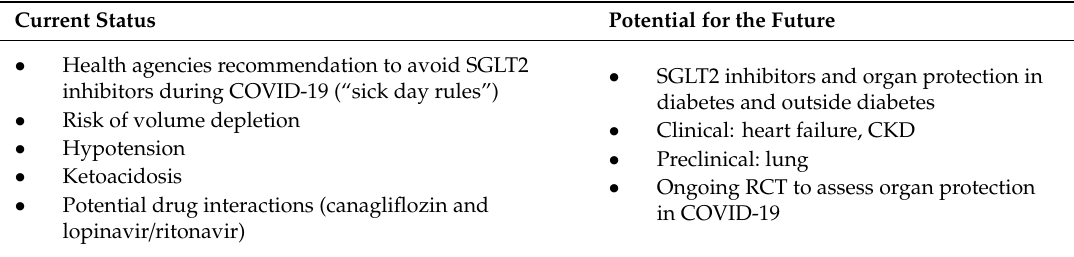
Table 1. SGLT2 Inhibitors and